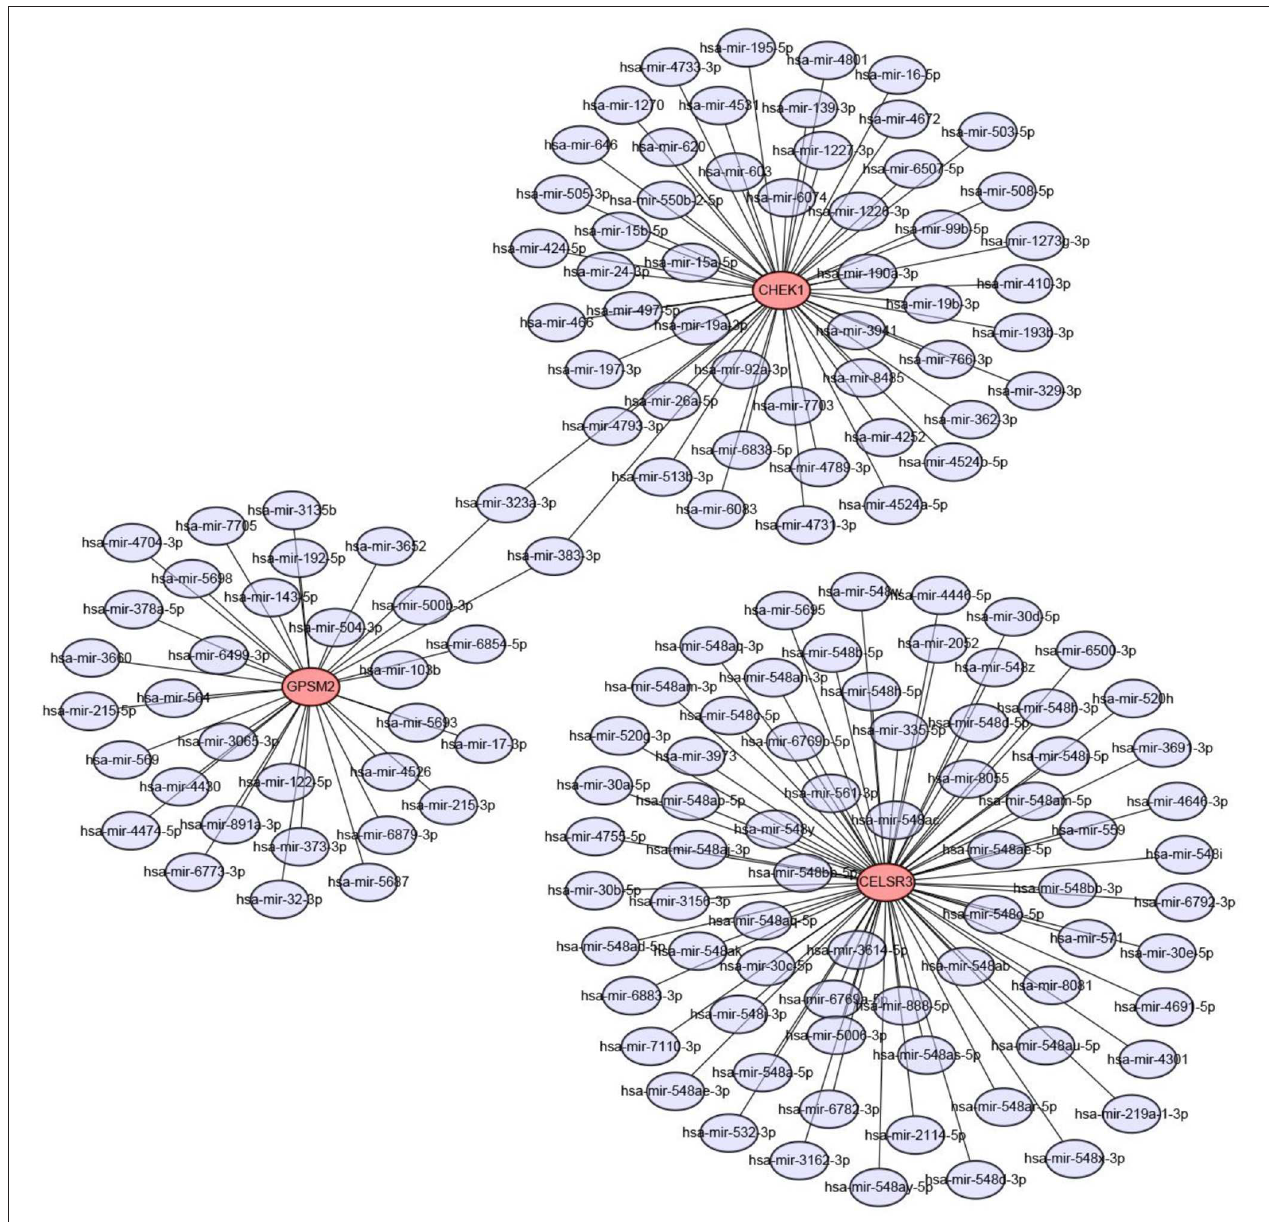
FIGURE 3 | Construction of CELSR3/GPSM2/CHEK1-miRNA network by miRNet database and Cytoscape software. that CELSR3, GPSM2, and CHEK1 were upregulated in hepatocellular carcinoma and linked to prognosis of patients with hepatocellular